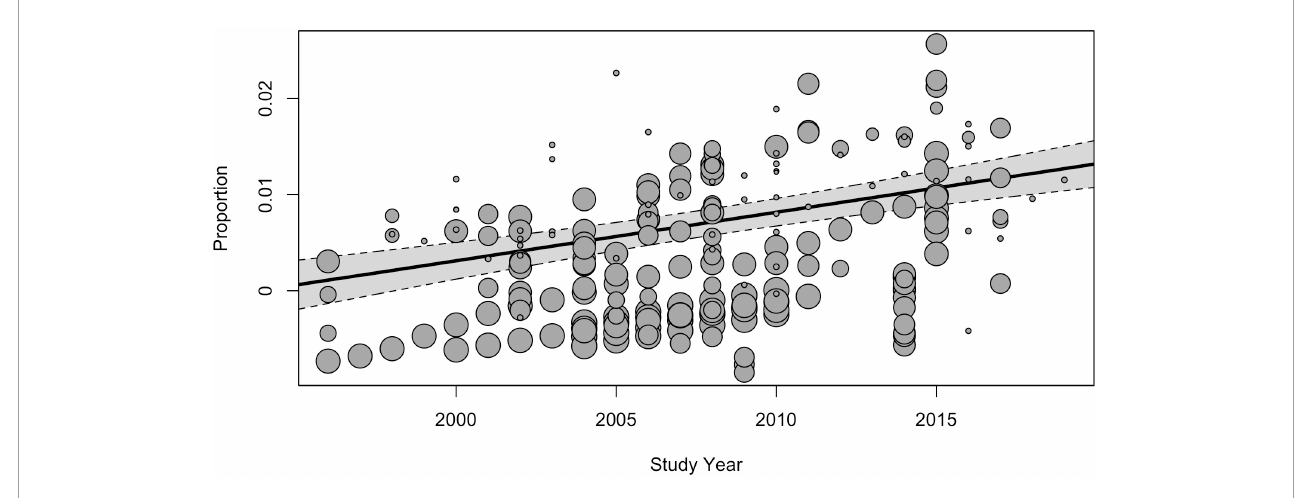
FIGURE4 The meta-regression analysis of the effect of the study time on the pooled prevalence of